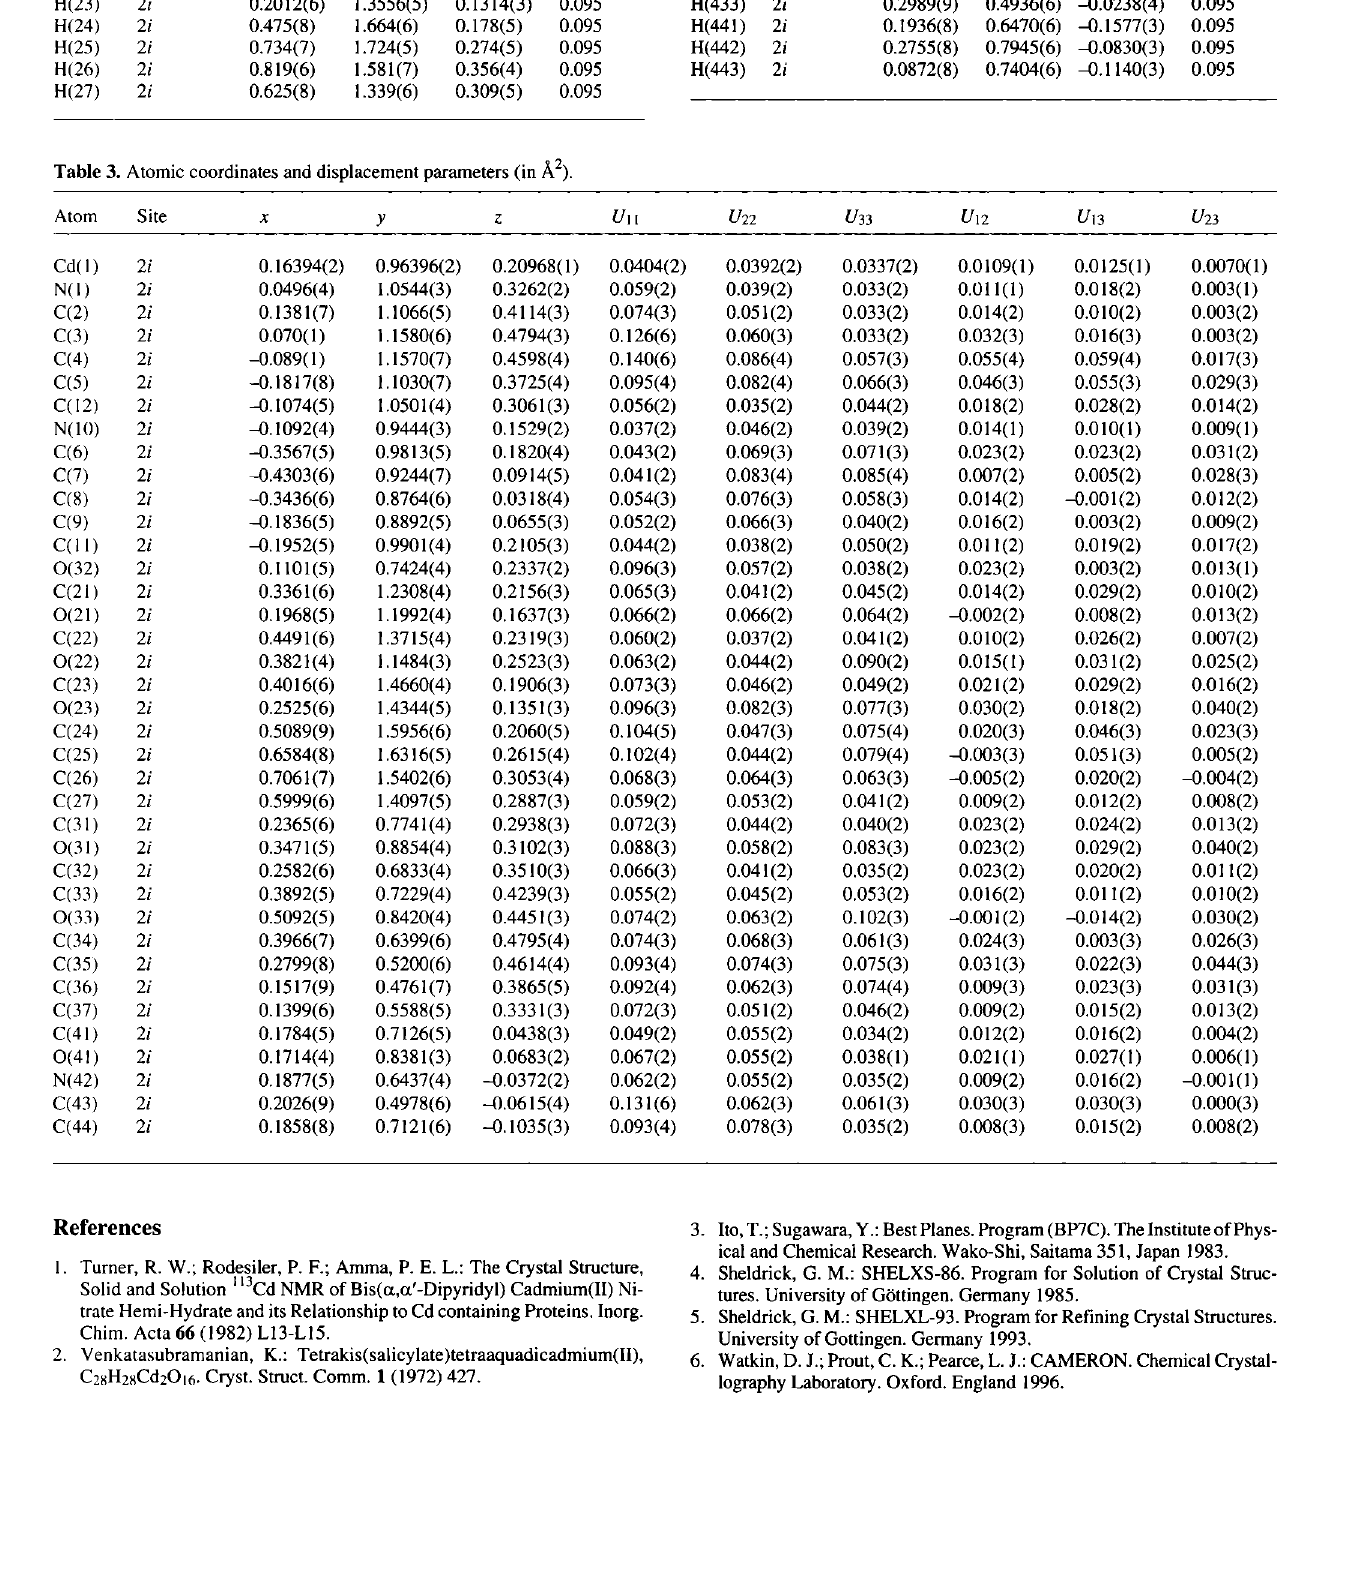
Table 3. Atomic coordinates and displacement parameters (in Ä 2